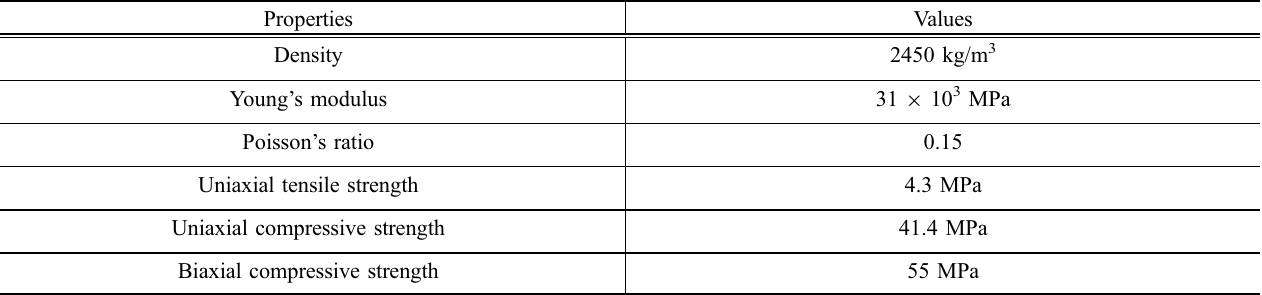
Table 4 Concrete properties for tip-over